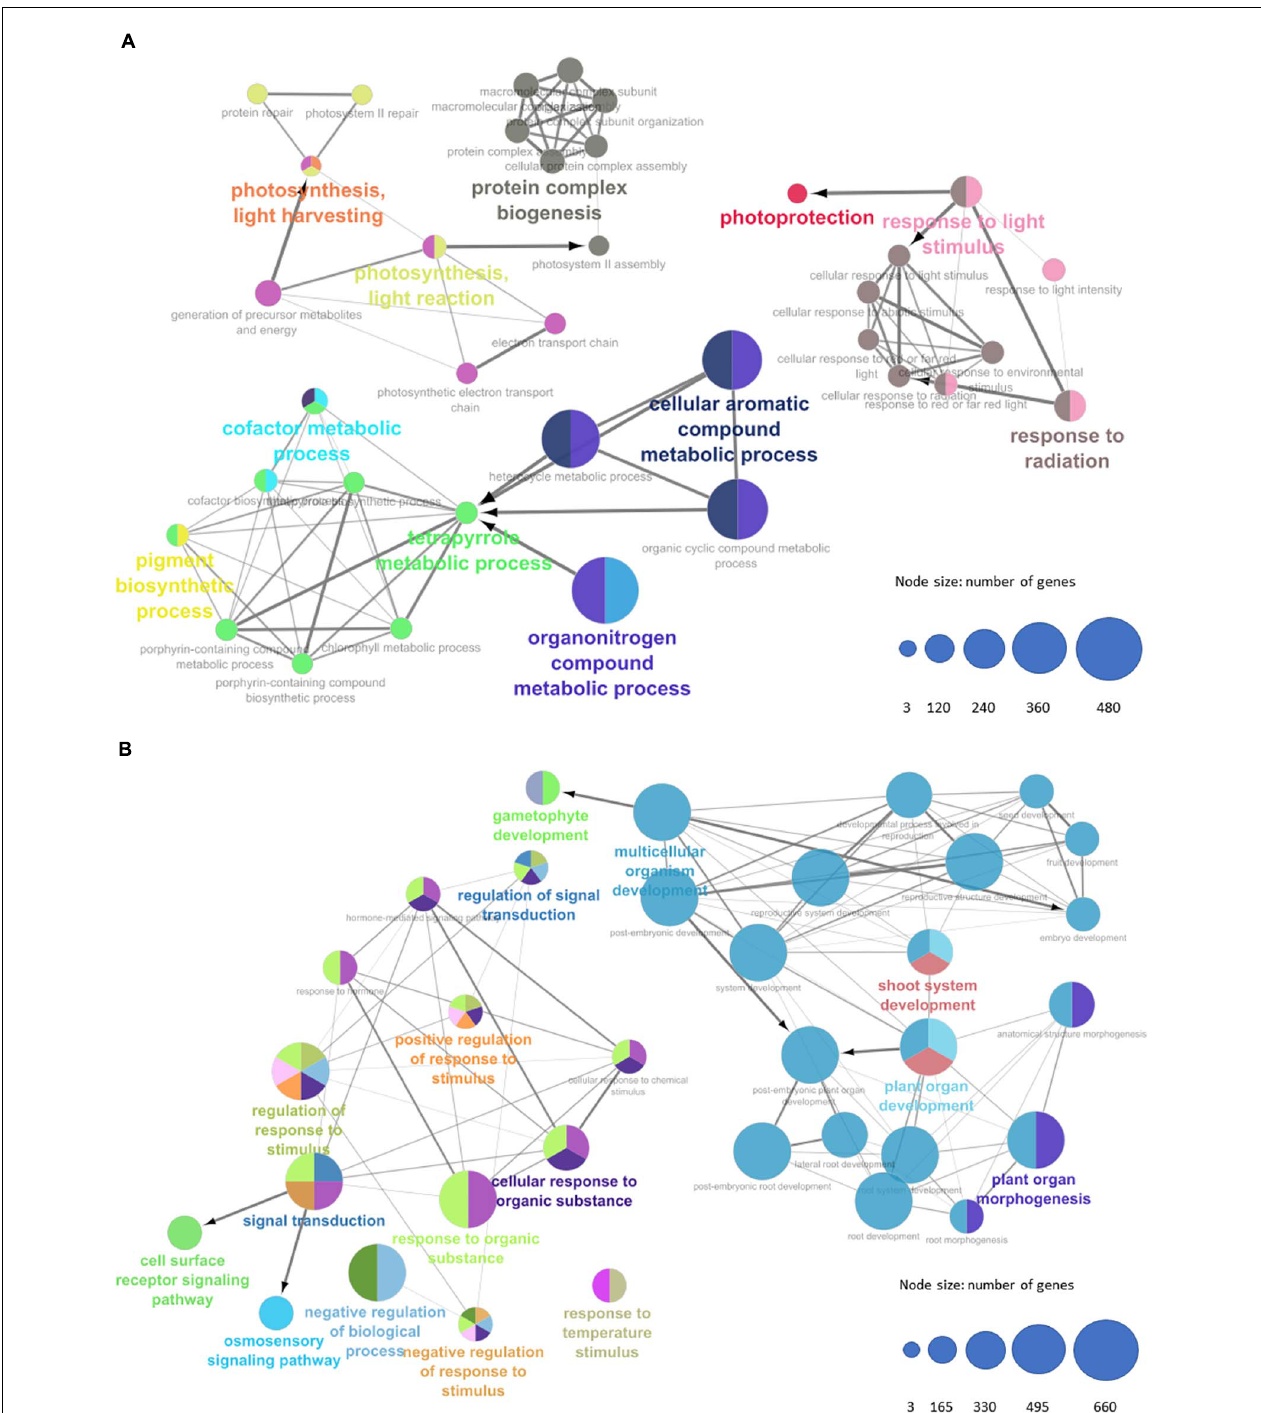
FIGURE 5 | Gene Ontology enriched terms network representing of biological processes for (A) upregulated transcripts and (B) downregulated transcripts. Node sizes represent number of genes per term (Bonferroni step-down p -value < 0.05).